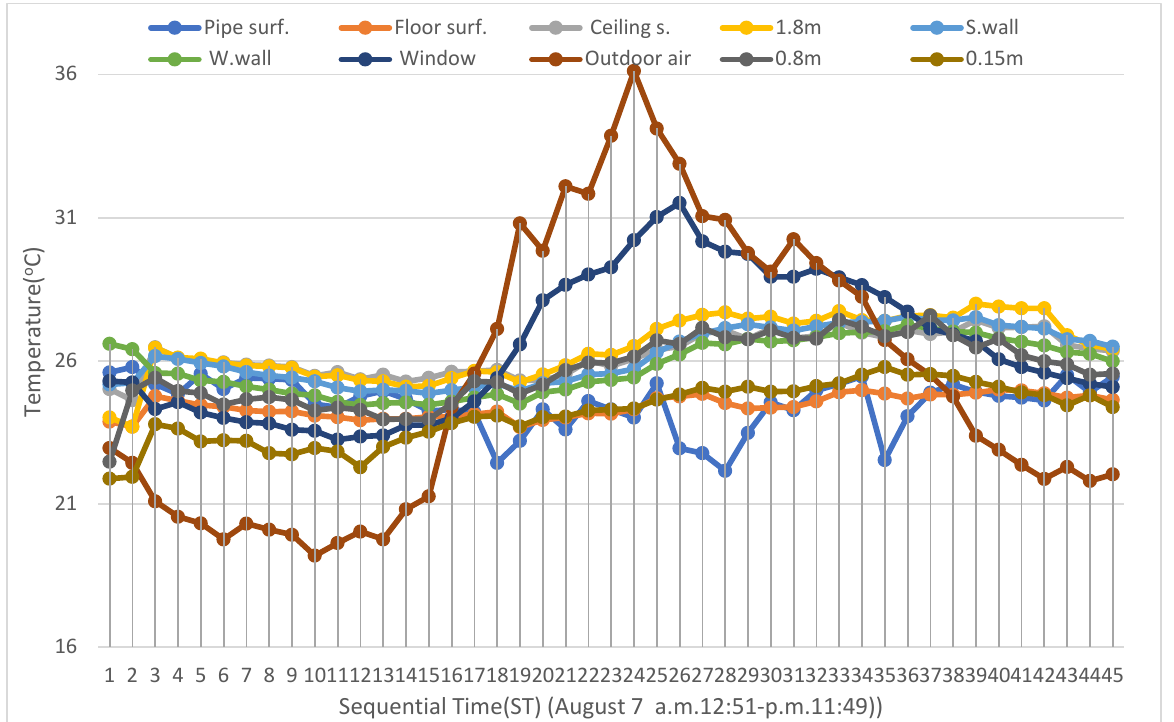
Figure 4. Temperature variations of the radiant cooling space depend on the time-sequential process.